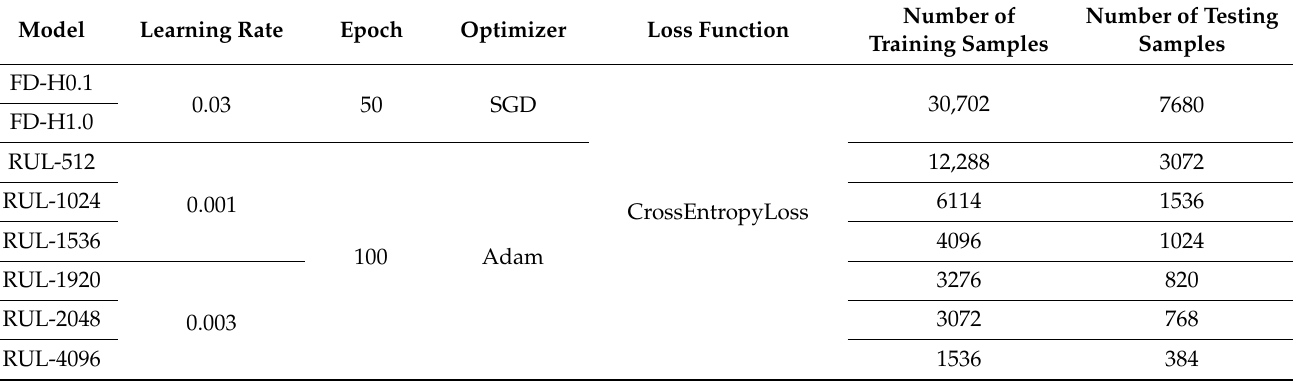
Table 3. Experimental parameter settings and number of samples in the gear pump